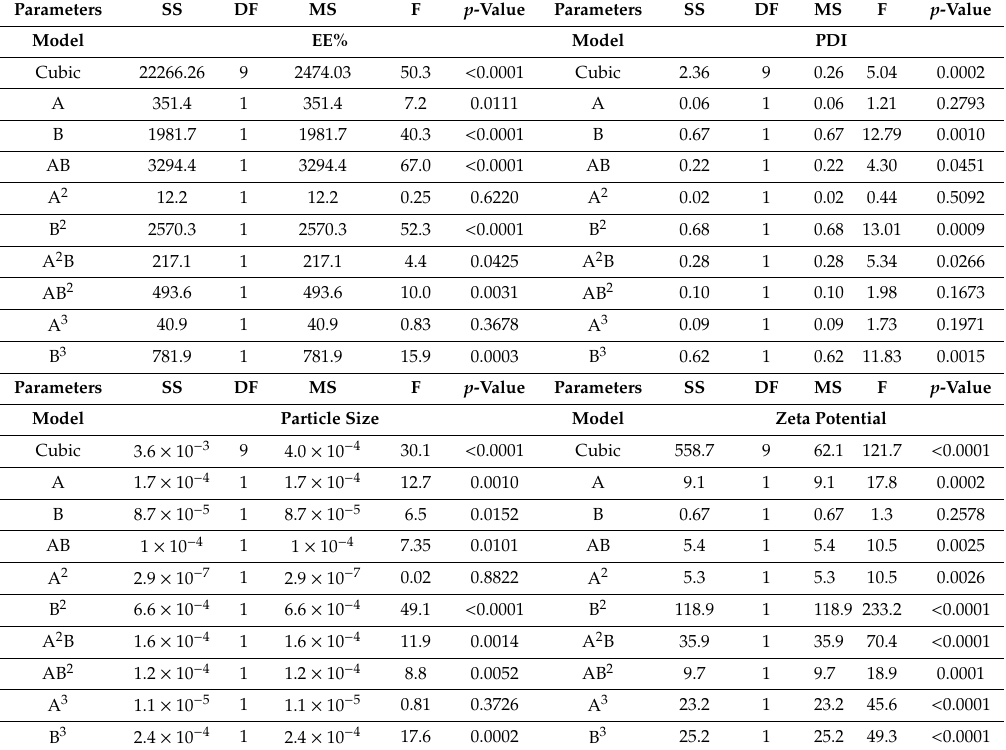
Table 3. Analysis of variance of the final models for measured